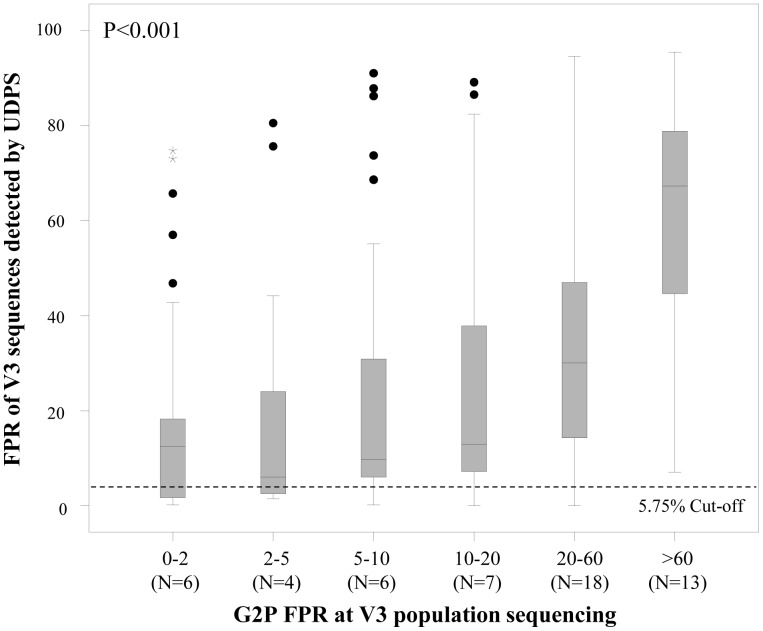
Box plot reporting the distribution of FPR values of V3 sequences obtained by UDPS, sorted according to the FPR value at population sequencing.The medians, interquartile ranges, upper and lower whiskers, and outlier values are shown. P-value was calculated through Kruskal-Wallis Test.